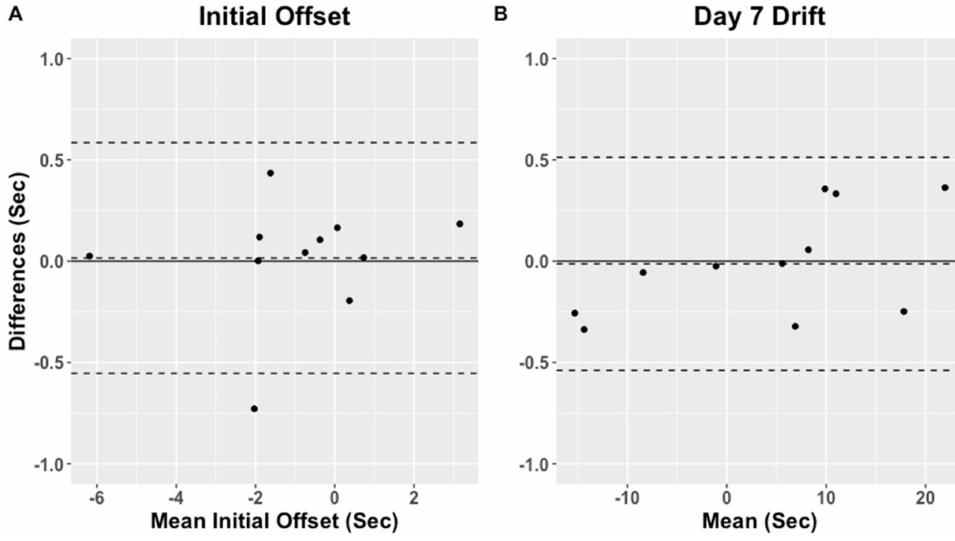
Figure 4. Bland-Altman plots of the initial offset ( A ) and the accumulated drift at day 7 ( B ) for the WH